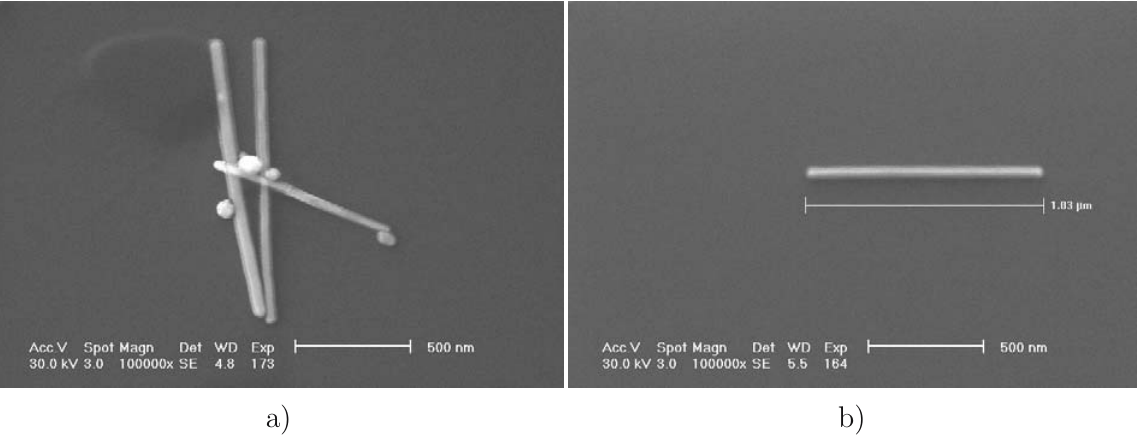
Fig. 3 SEM images of gold nanorods prepared in the presence of 1 M CTAB